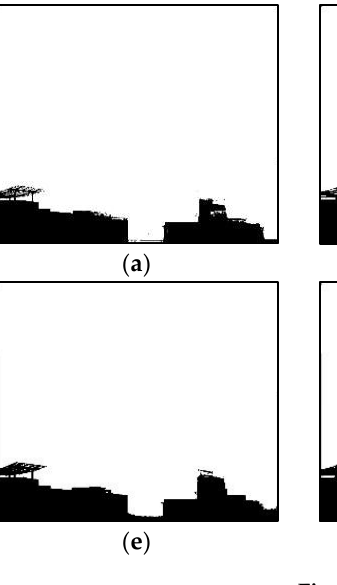
Figure 2. Segmentation example of sky region, ( a – h ) show the different results of the sky segmentation under different parameters, ( a ) th1 = 60, th2 = 60, th3 = 180, ( b ) th1 = 70, th2 = 70, th3 = 190, ( c ) th1 = 70, th2 = 80, th3 = 190, ( d ) th1 = 70, th2 = 80, th3 = 200, ( e ) th1 = 70, th2 = 90, th3 = 200, ( f ) th1 = 70, th2 = 95, th3 = 200, ( g ) th1 = 70, th2 = 95, th3 = 205, ( h ) th1 = 70, th2 = 95, th3 = 215.